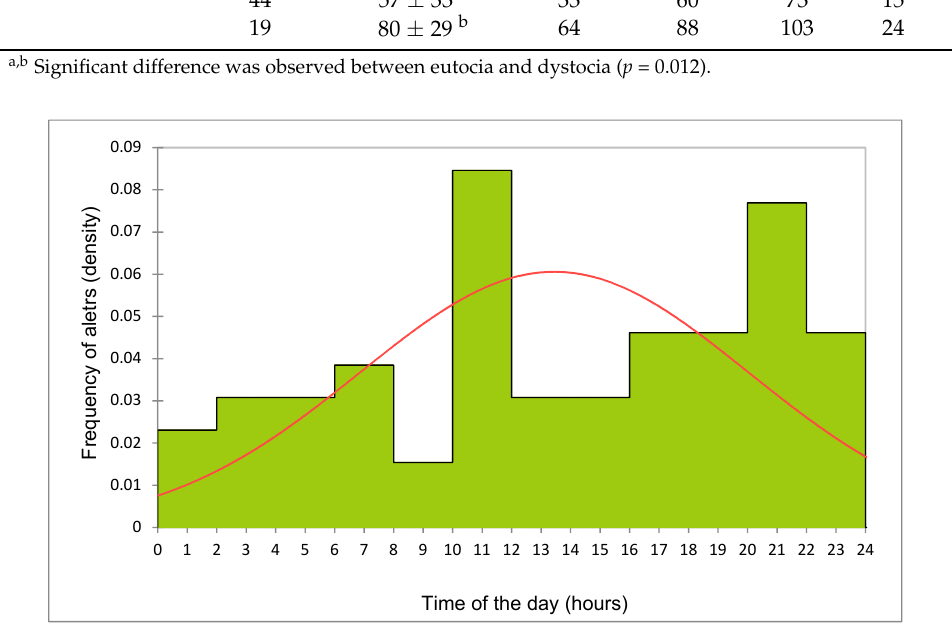
Figure 5. Distribution of phone alert reception for imminent calving, during the day, expressed as the proportion of calls within 24 h (density). The red line describes the fitted distribution of calls.